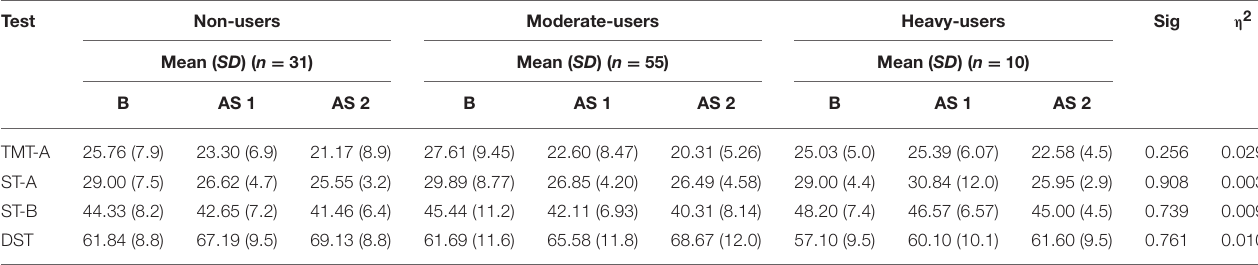
TABLE 4 | Mean Neuropsychological Test Score for 3,4-methylenedioxymethamphetamine (MDMA) users and non-users related to attention and information processing speed.